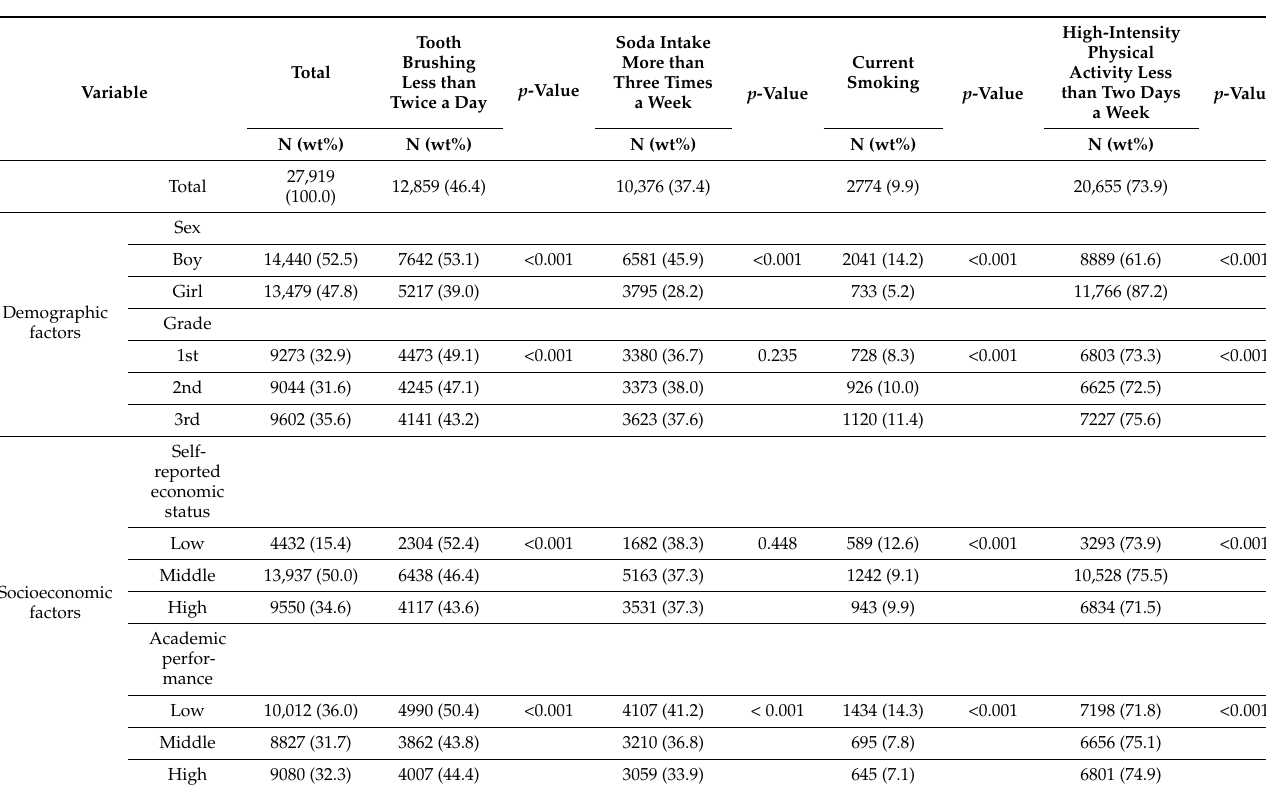
Table 1. Health behaviors according to the students’ general